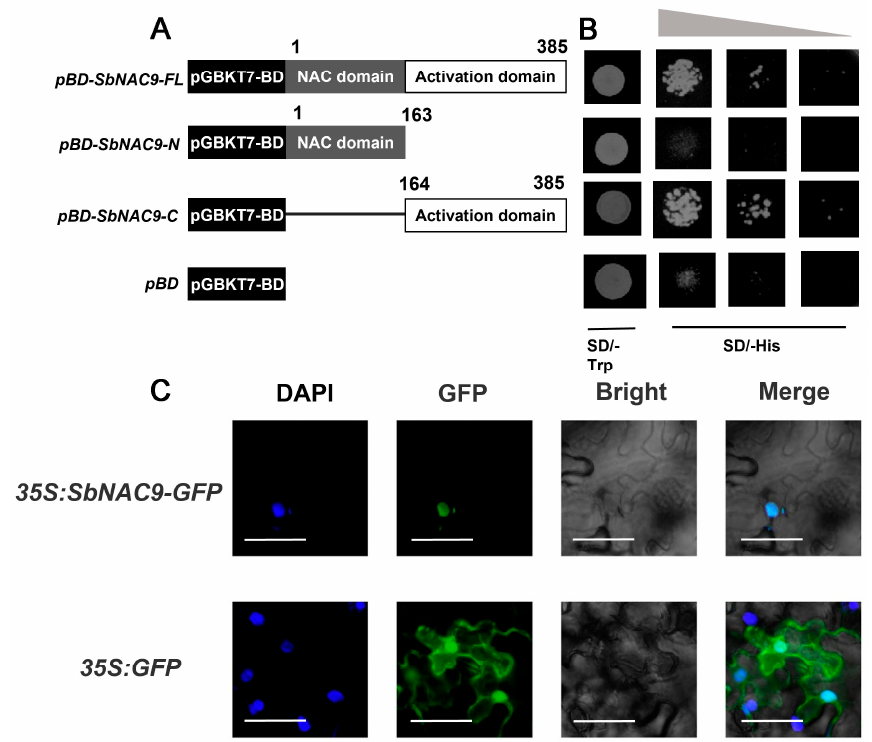
Figure 2. SbNAC9 functions as a transcriptional activator. ( A ) Schematic diagrams of constructs in SbNAC9 transcriptional activation assay. ( B ) Transcriptional activation of SbNAC9 . Yeast cells were diluted to 1, 10 − 1 , 10 − 2 from the left panel to the right panel. pBD-SbNAC9-FL , full-length CDS of SbNAC9 ; pBD-SbNAC9-N , N-terminal of SbNAC9 ; pBD-SbNAC9-C , C-terminal of SbNAC9 ; and pBD , pGBKT7-BD vector. pGBKT7-BD was used as a negative control. ( C ) Subcellular localization of SbNAC9 in tobacco leaves. DAPI (2-(4-Amidinophenyl)-6-indolecarbamidine dihydrochloride) channel represents the signal of nucleus colored in blue. GFP channel represents the signal of SbNAC9 ‐ GFP or GFP colored in green. Merge indicates combination of GFP (green fluorescent protein), DAPI, and Bright together colored in cyan. Bars indicate 50 μ m.